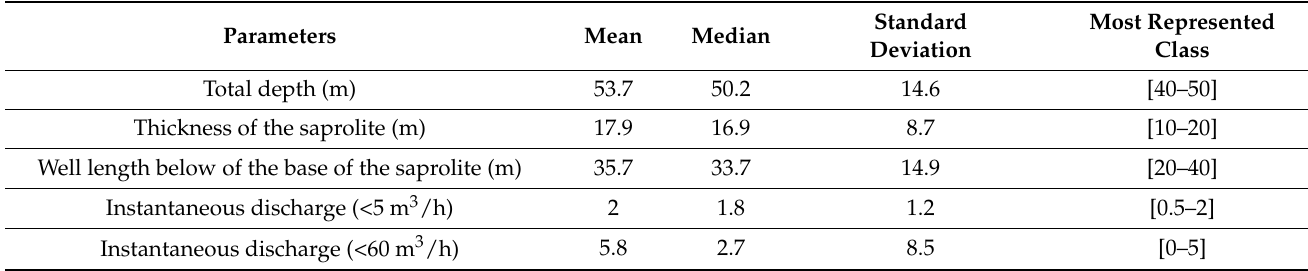
Figure 7. Histograms of the parameters from the database or computed from it (N = 445). ( a ) Total well length (X axis = well length (m), Y axis: frequency (%)); ( b ) thickness of the saprolite (X axis = length of the saprolite (m), Y axis: frequency (%); ( c ) well length below the base of the saprolite (X axis = well length under the base of the saprolite (m), Y axis: frequency (%)); ( d ) instantaneous discharge (all wells) (X axis = instantaneous discharge (m 3 /h), Y axis: frequency (%)), and ( e ) instantaneous discharge (wells with discharge < 5 m 3 /h) (X axis = instantaneous discharge (m 3 /h), Y axis: frequency (%)). Table 6. Elementary statistics computed from the ONEP database (N =